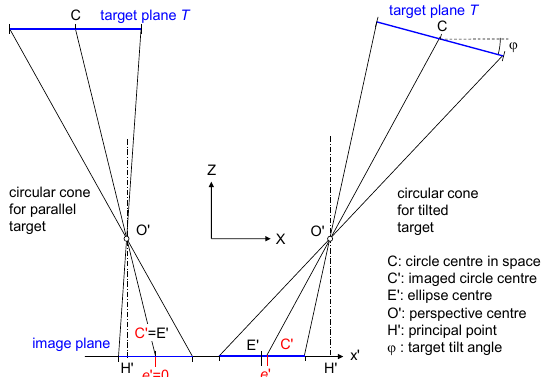
Figure 5: Eccentricity in projection of a circular target left: parallel planes; right: tilted planes The centre of the image ellipse is identical to the imaged circle centre only in the case where circle plane and image plane are parallel to each other (Figure 5 left). The effect is well known and was investigated by Ahn (1997), and by Dold (1997) for high-accuracy photogrammetry systems. Dold has shown that eccentricity depends on circle radius, principal distance and exterior orientation. It becomes zero when both planes are parallel. The eccentricity increases for increasing target diameters, viewing angles and image scales. With respect to the angle between target plane and image plane, the function shows a sinusoidal form (example in Figure 7 right).